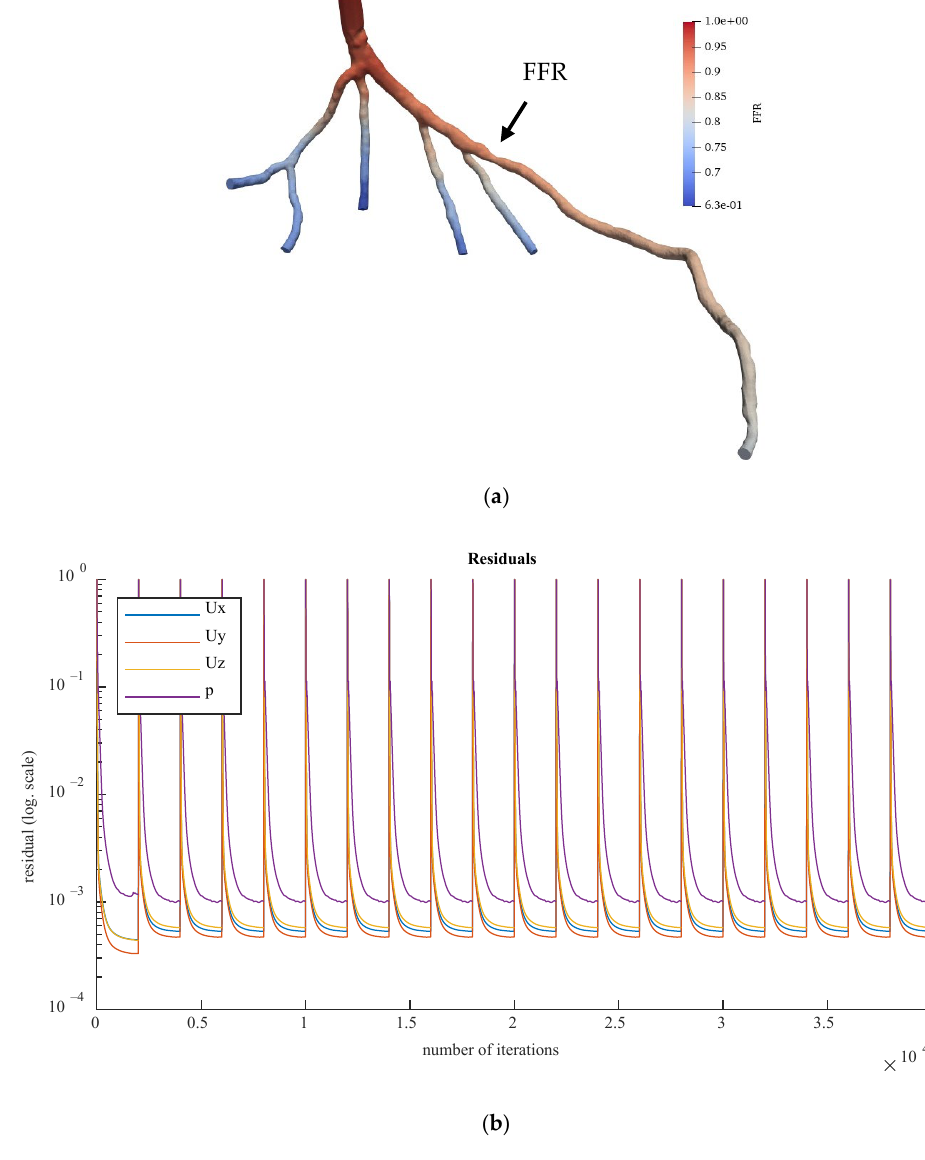
Figure 17. ( a ) FFR distribution with shape of CHN03 steady-state PBA model and ( b ) PBA residual history.